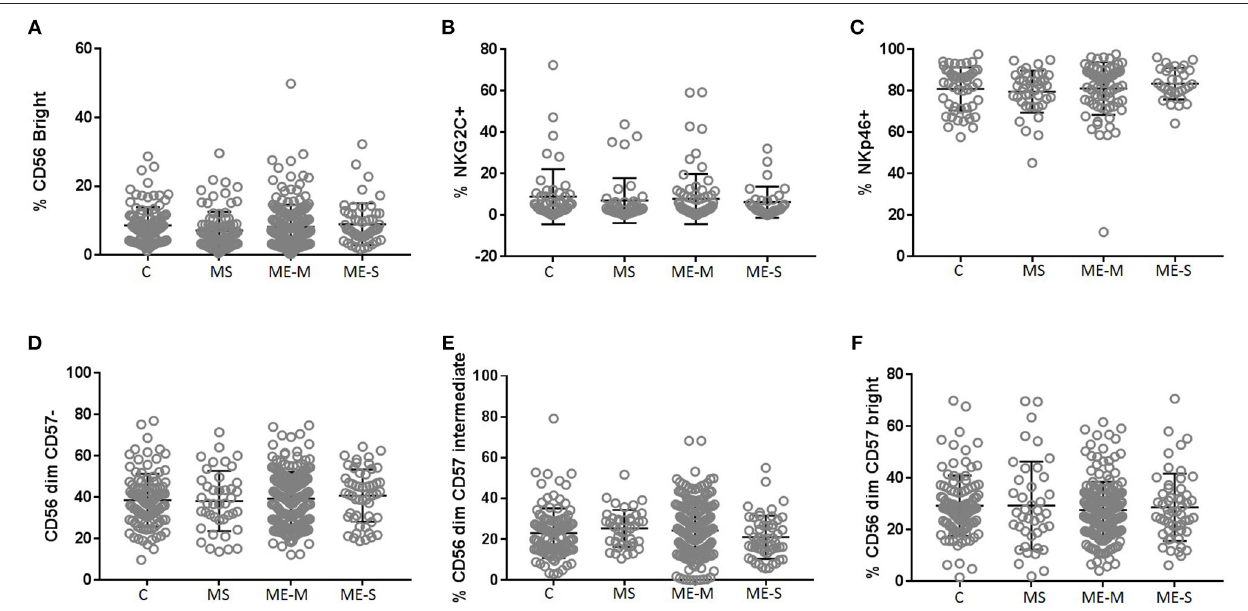
FIGURE 7 | Proportions of Natural Killer Cell subsets in PBMC from people with ME/CFS, people with MS and healthy controls. By flow cytometry, NK cells were defined as CD3 − CD56 + as shown in Figure 1 . Subpopulations were defined as CD56 bright (A) , NKG2C + (B) , NKp46 + (C) , CD56 dim CD57 − (D) − , CD56 dim CD57 intermediate (E) , or CD56 dim CD57 bright (F) for PBMC from mild/moderately affected ME/CFS (ME-M) or severely affected ME/CFS (ME-S), multiple sclerosis (MS) patients or healthy control individuals (C) . Populations of each type of NK cell were compared across clinical groups by ANOVA, but no significant differences were observed ( P < 0.05). The bars show the Mean ± SD. Data are from healthy controls (C, n = 107), multiple sclerosis (MS: n = 46), mild/moderate ME/CFS (ME-M: n = 197), and severely affected ME/CFS (ME-S: n = 54) for (A,D–F) and from C ( n = 50), MS ( n = 41), ME-M ( n = 76), and ME-S ( n = 32) for (B,C) .